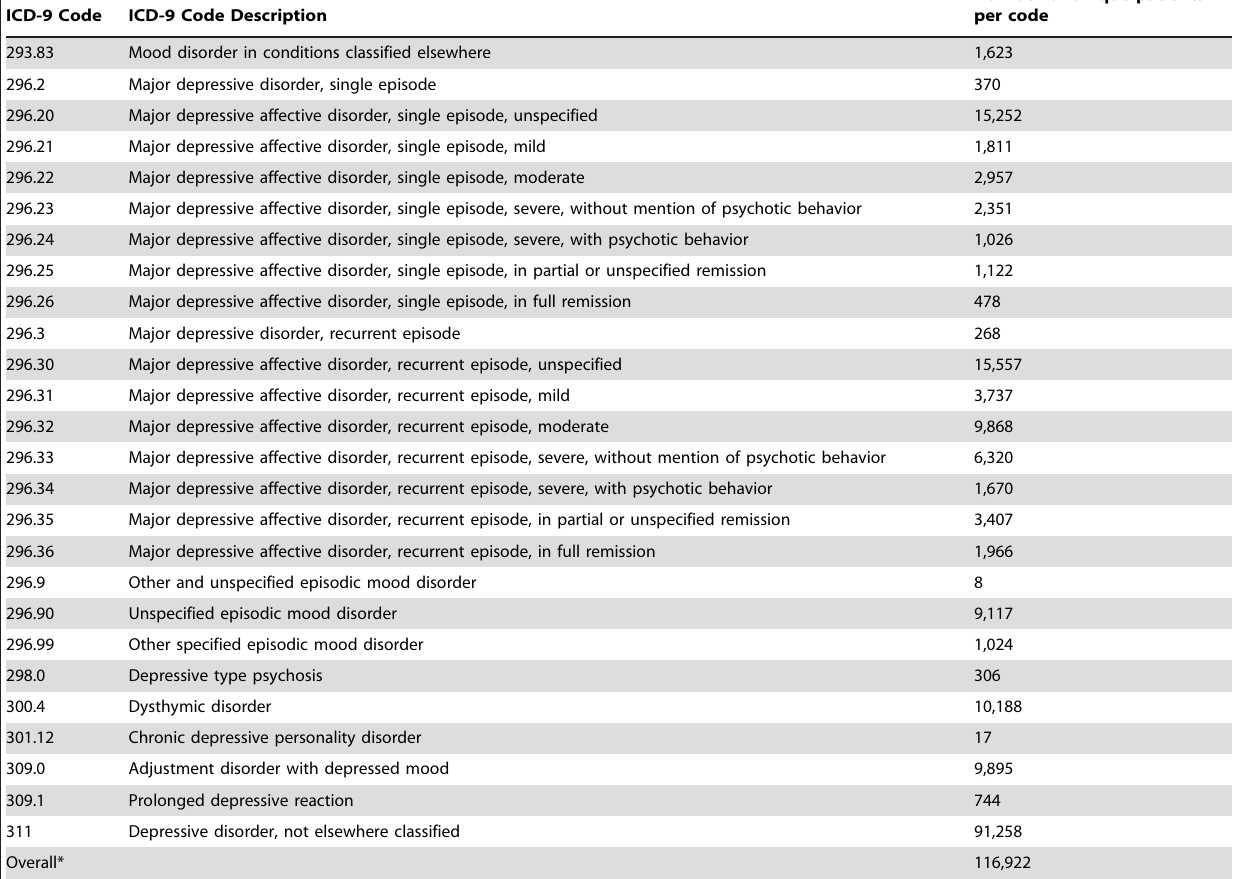
Table 1. ICD-9 codes used to identify cases of